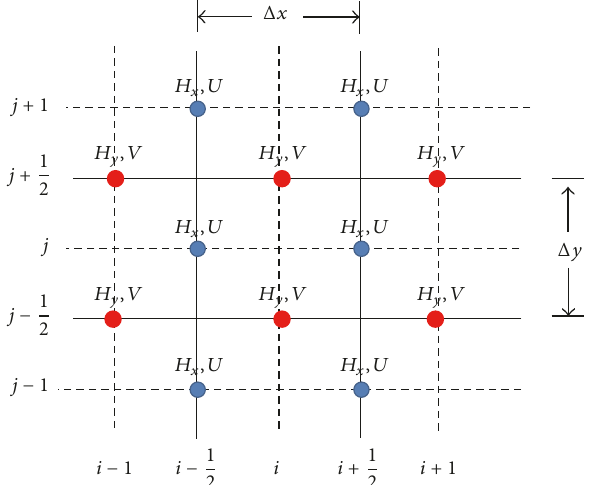
Figure 4: The values of vector 𝐻 𝑥 , 𝐻 𝑦 , 𝑈 , and 𝑉 represented the solution at the midpoints of the grid